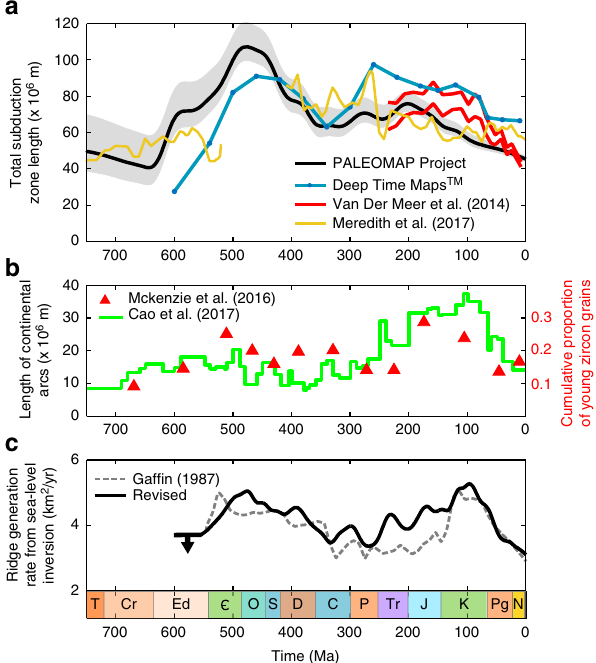
Fig. 3 Subduction zone lengths. a Total global subduction zone length derived here from the plate tectonic reconstructions of the PALEOMAP project and from Deep Time Maps TM , compared to lengths derived from seismic tomography (Van Der Meer et al. 21 shown in red) and from kinematic modelling 18 . Error estimations (grey) based on observations, direct plate imaging, timing of collisions and relative plate motions (see ‘ Methods ’ and Supplementary Fig. 2). b Global length of continental arcs 17 (left axis) and the cumulative proportion of young Zircon grains 16 (shown in red, right axis). c Ridge generation rate via revised sea-level inversion method 29 , original predictions shown as grey dashed line, revised predictions (see text) shown as black line. See ‘ Methods ’ for full